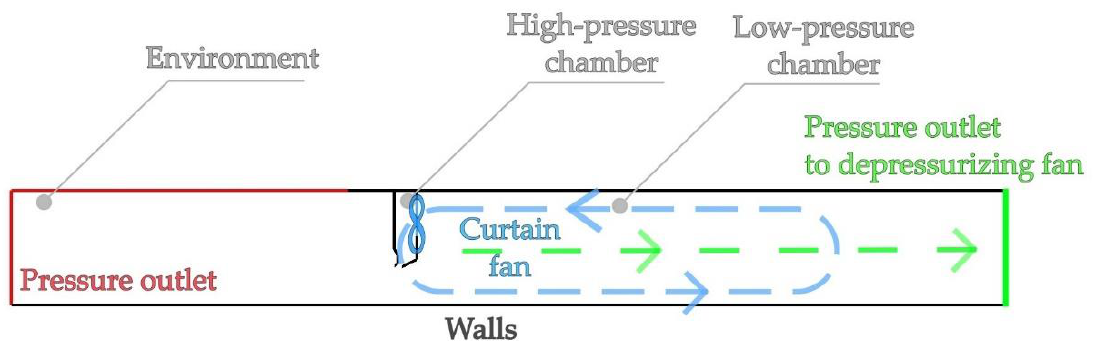
Figure 9. Scheme of FDDG with air curtains and depressurizing fan.